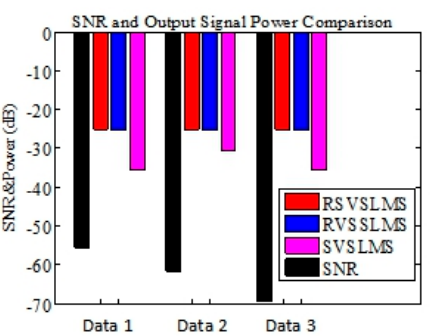
Figure 17. Comparison of pseudo-synthetic telemetry processing results for time range 336 to 346 s. The main signal SNR was varied between − 55 dB and 69.4 dB. The results were obtained by using multi-channel noise cancellation techniques: ( a ) regularized variable step-size LMS (RVSSLMS) technique; and ( b ) regularized sigmoid variable step-size LMS (RSVSLMS) technique.